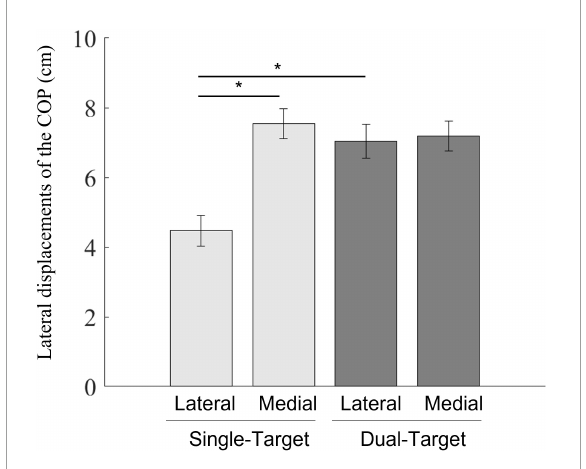
FIGURE4 Mean lateral displacements of the COP between the position at the onset of the COP movements and the position at the initial lateral peak of the COP movements toward the swing foot side. Light gray bars represent average values in the single-target condition, and dark gray bars represent average values in the dual-target condition. Error bars represent standard errors of the mean. An asterisk (*) indicates a significant difference in group means based on a post hoc analysis ( p <